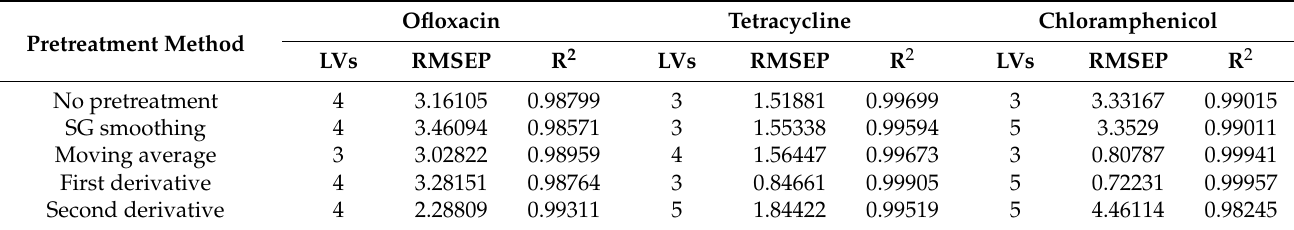
Table 5. LVs, RMSEP, and R 2 using different preprocessing